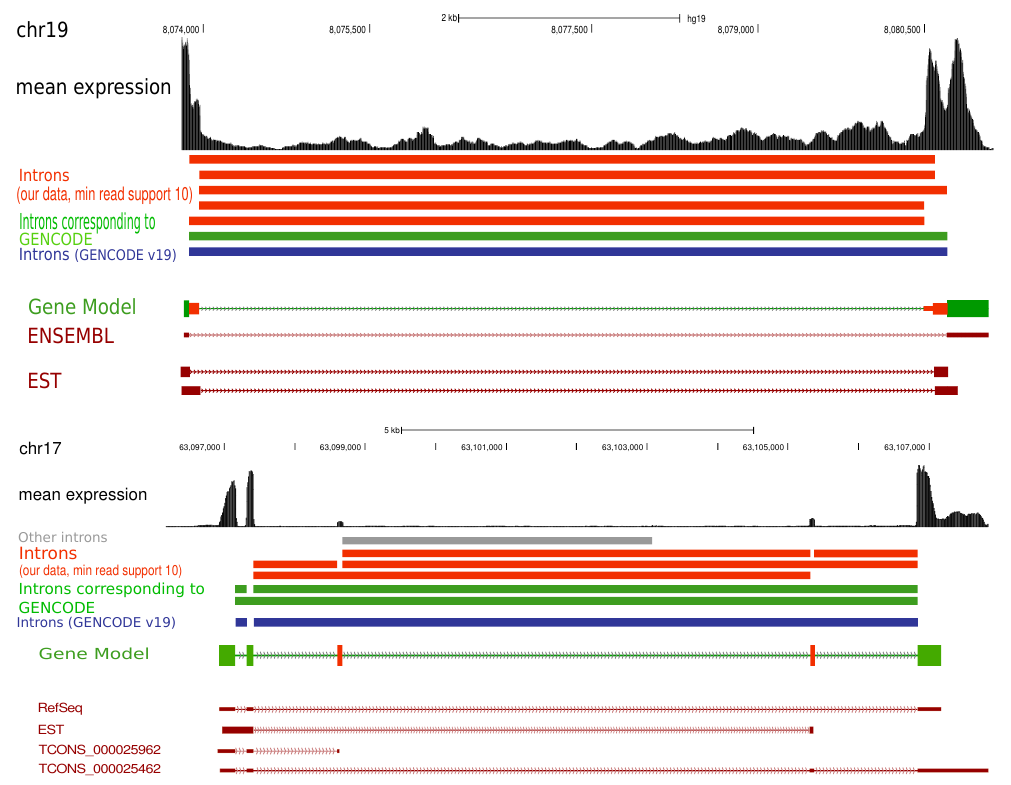
Figure 3. Two examples with previously unannotated splice junctions and introns. ( Top ) In ENSG00000267939, we find six introns and two additional exons compared to a single intron described in GENCODE v19. ( Below ) For ENSG00000263470 we find eight introns plus a likely false positive compared to two introns in